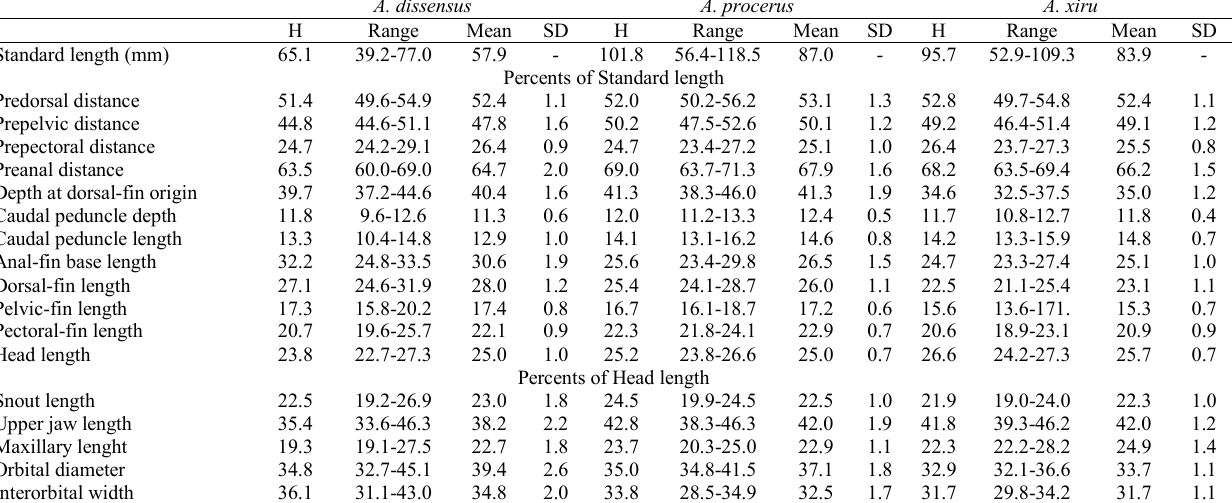
Table 1. Morphometric data for new species of Astyanax , A. dissensus (n = 75), A. procerus (n = 30), and A. xiru (n = 36), based on type series indicated in the text. The range included the holotype (H). SD = standard